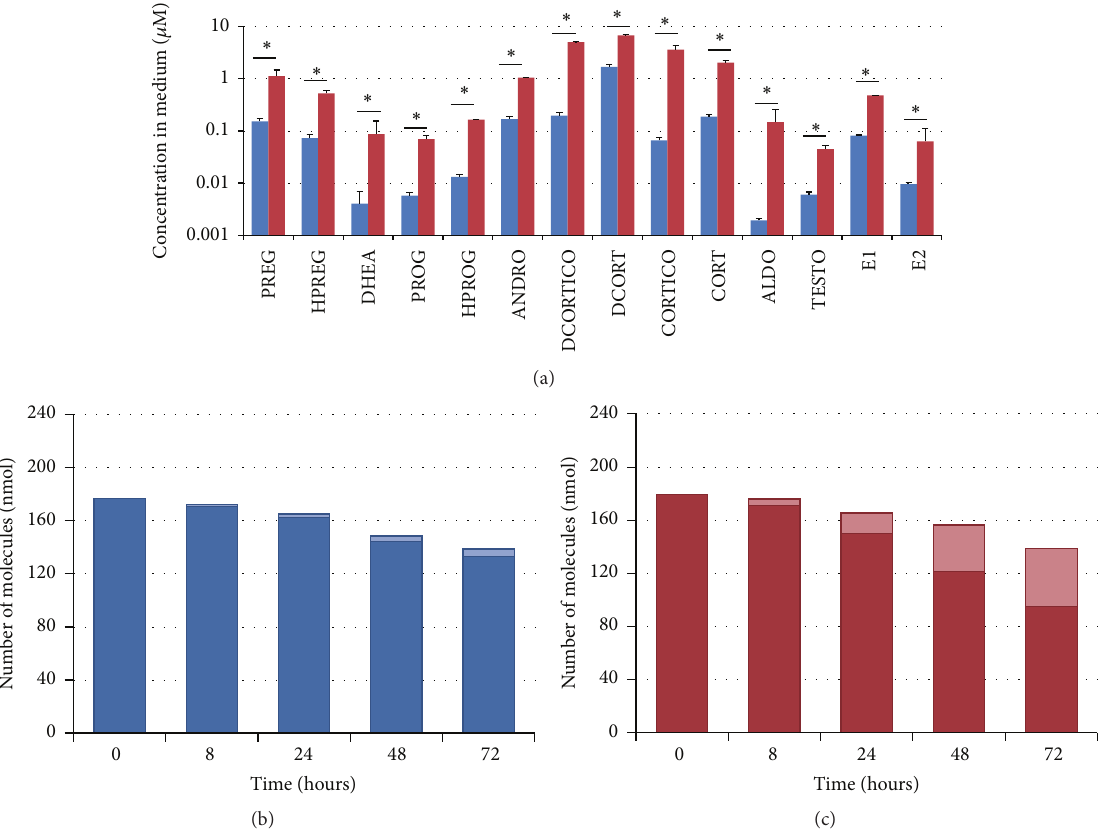
Figure 2: Experimental data of metabolic profiling of adrenal steroid hormones and the mass balance. Concentrations of steroid hormones secreted from NCI-H295R cells in the culture medium at 72 h after stimulation were compared with the untreated condition and the stimulated condition by 50nM ACTH, 20 𝜇 M forskolin, and 100nM angiotensin II (a). Net molecular amounts including cholesterol and steroid hormones in the culture medium and intracellular space are plotted at five time points (0, 8, 24, 48, and 72 h after stimulation) under the untreated condition (b) and the stimulated condition (c). In the bar graphs, dark and light bars indicate the amount of cholesterol and adrenal steroids, respectively. All data are shown as the mean ± SD ( 𝑁 = 4 ). ∗ 𝑝 values corrected by the familywise error rate < 0.01. PREG: pregnenolone, HPREG: 17 𝛼 -hydroxypregnenolone, DHEA: dehydroepiandrosterone, PROG: progesterone, HPROG: 17 𝛼 - hydroxyprogesterone,DIONE:androstenedione,DCORTICO:11-deoxycorticosterone,DCORT:11-deoxycortisol,CORTICO:corticosterone, CORT: cortisol, ALDO: aldosterone, and TESTO: